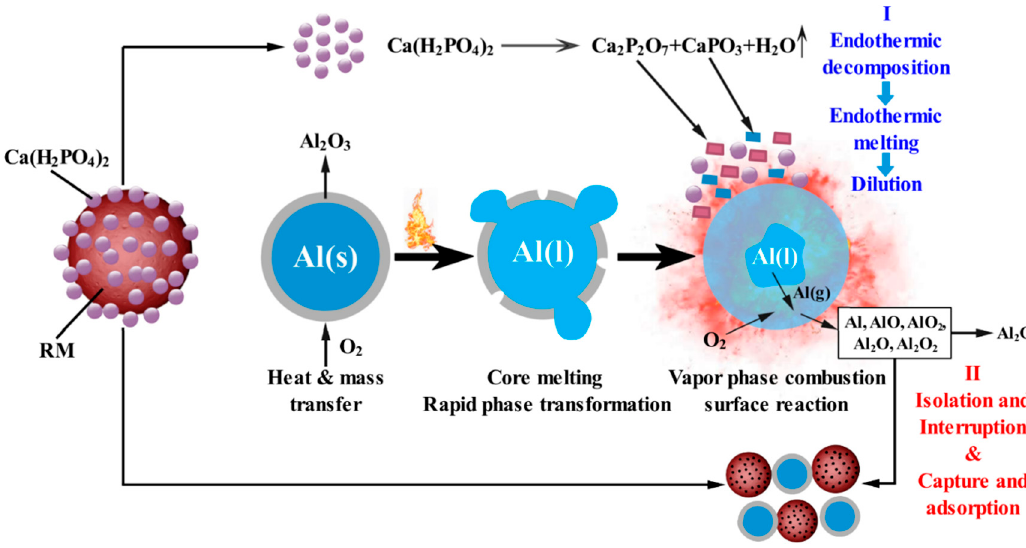
Figure 12. Sketch showing how Ca(H 2 PO 4 ) 2 /RM composite powder suppresses aluminum dust explosion.